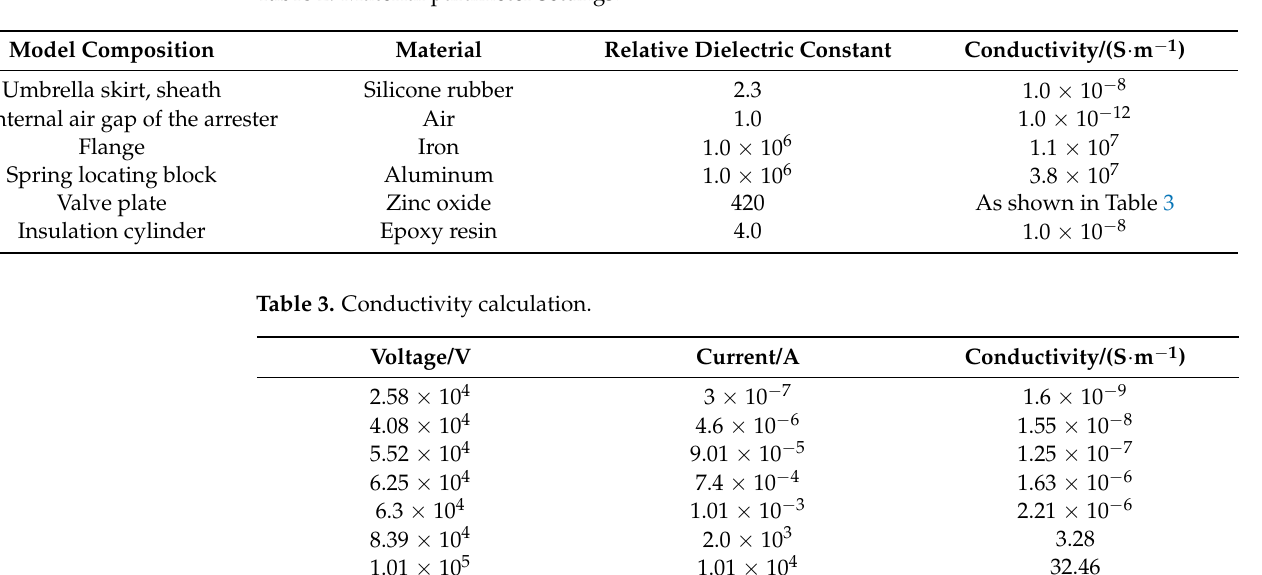
Table 2. Material parameter settings.